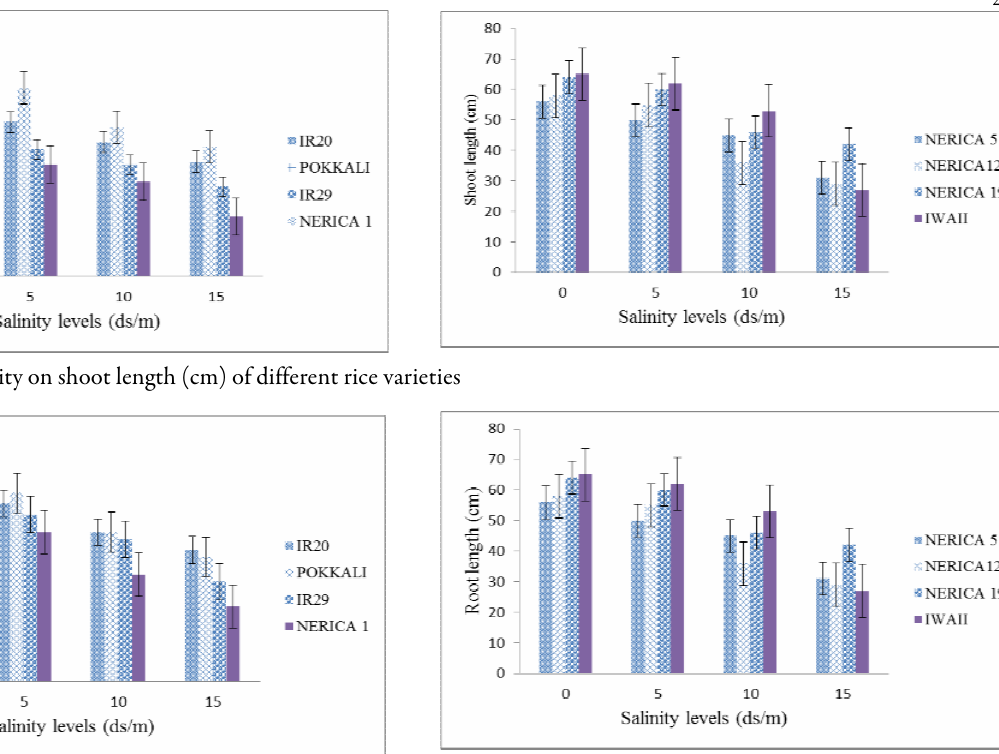
Fig. 2. Effect of salinity on root length (cm) of different rice varieties Tab. 4. Effect of salinity on shoot dry weight (g/5 plants) of different rice varieties